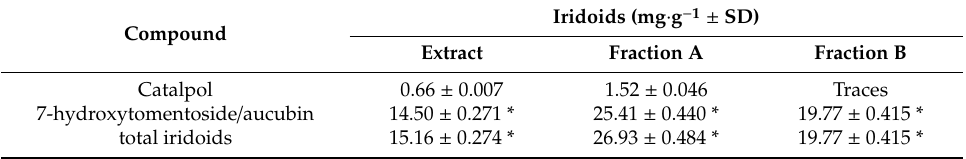
Table 2. Content of iridoids in the extract from Paulownia Clone in Vitro 112, and its fractions. Compound